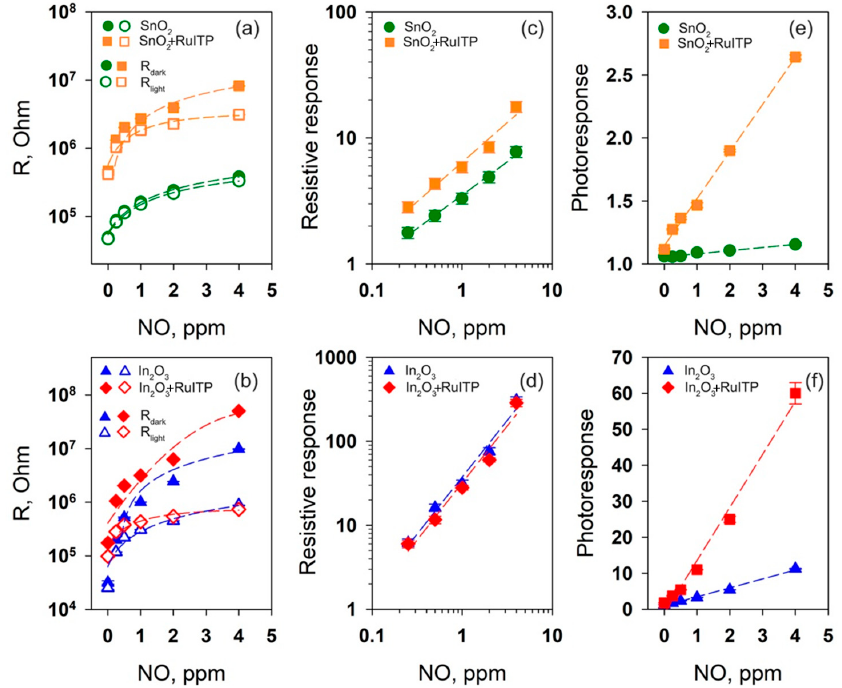
Figure 10. Room-temperature R dark and R light resistance values ( a , b ), resistive response ( c , d ), and photoresponse ( e , f ) depending on NO concentration for SnO 2 based ( a , c , e ) and In 2 O 3 based ( b , d , f ) samples.